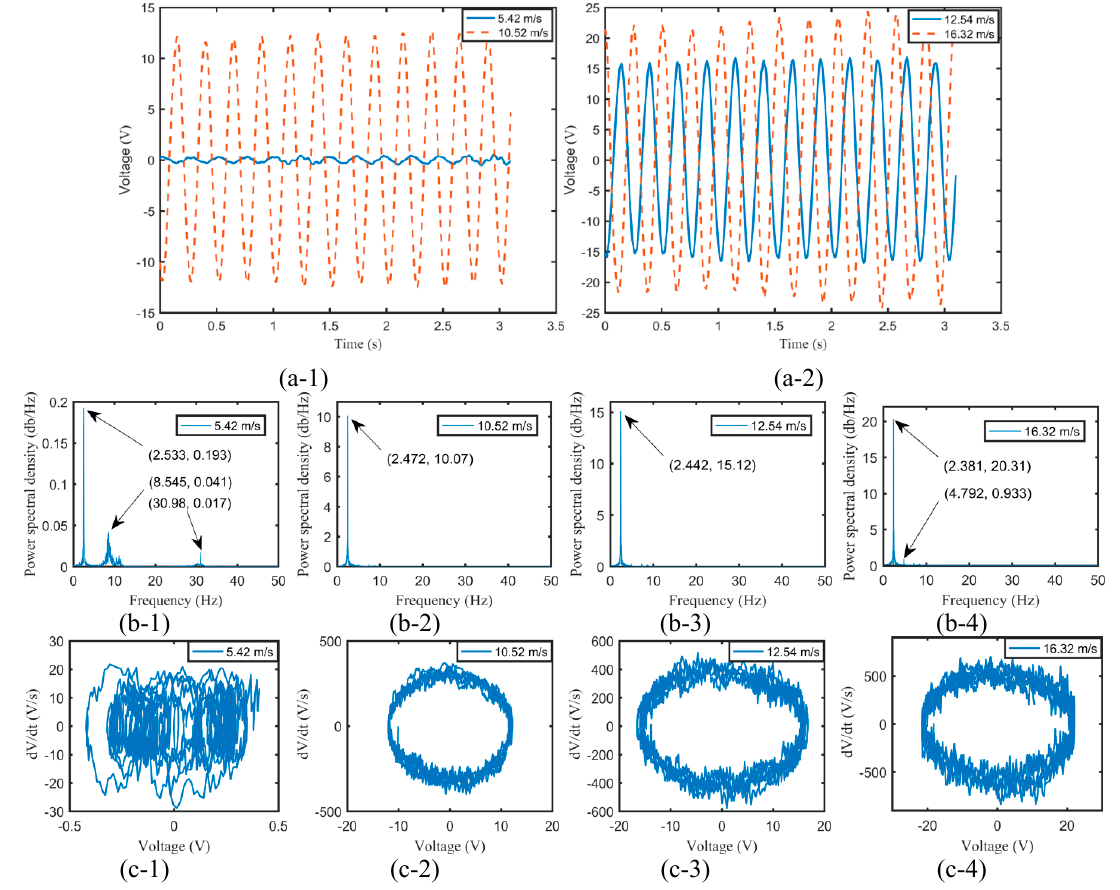
Figure 3. The time histories ( a ), the power spectral densities ( b ), and the phase portraits ( c ) of output voltages for EH-180-1 at 5.42, 10.52, 12.54, and 16.32 m/s. voltages for EH-180-1 at 5.42, 10.52, 12.54, and 16.32 m /